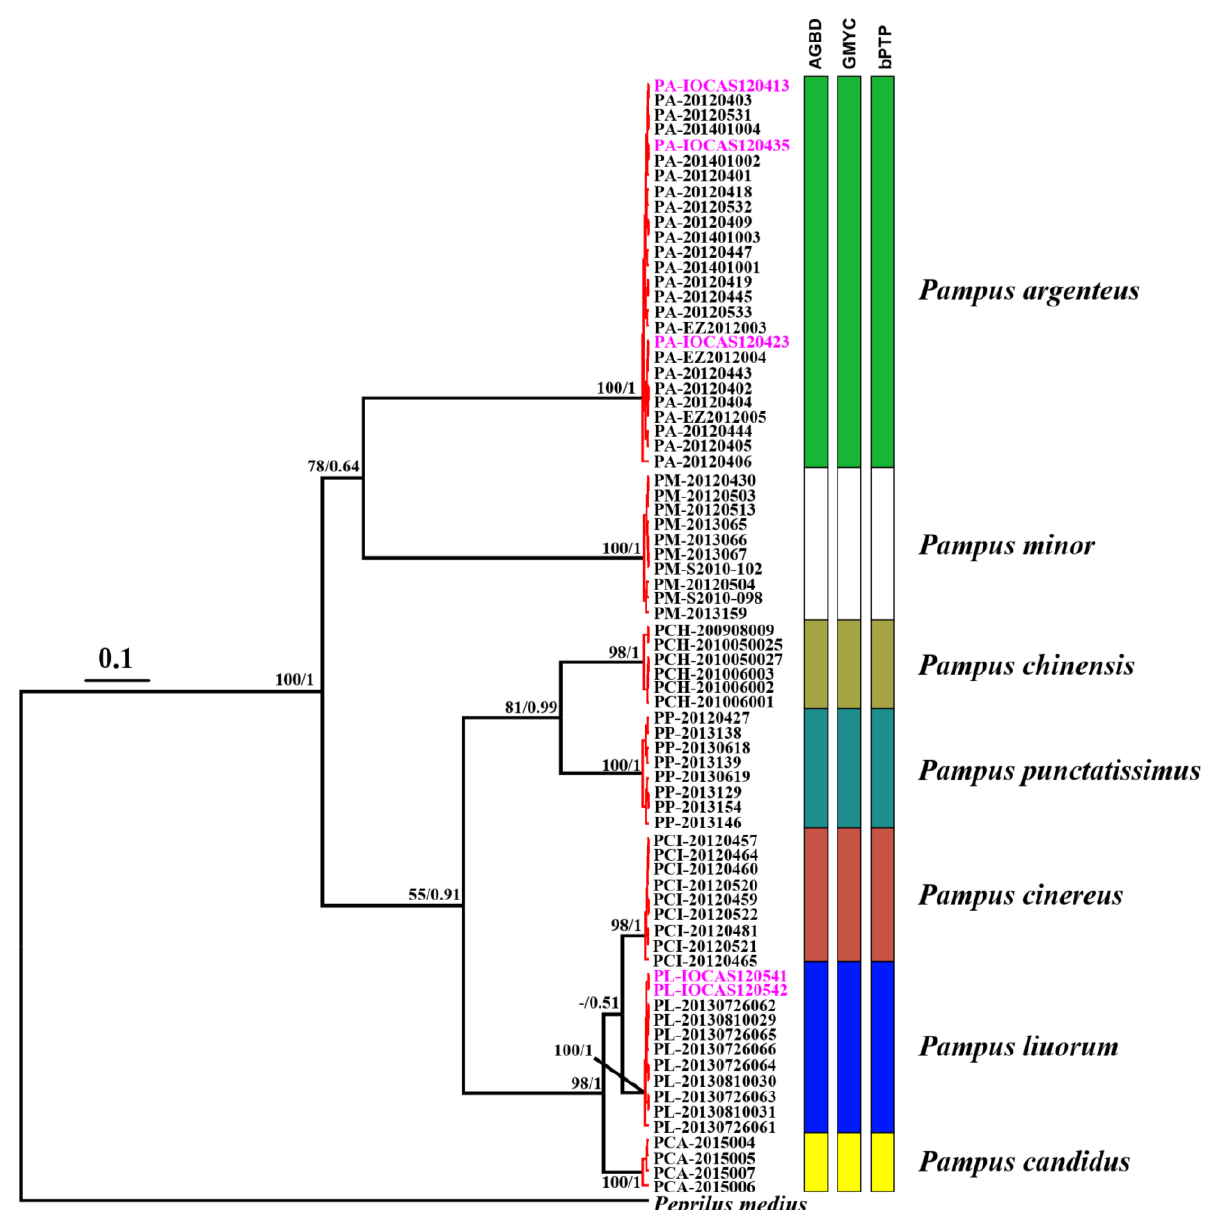
Figure 4. Maximum likelihood tree of the Pampus species inferred from concatenated dataset of COI and Cyt b sequences. Bootstrap values (before slash) and posterior probabilities (after slash) are shown on each node; “ - ” on the node indicates that the node was not included in the maximum likelihood or Bayesian analyses. Results of the two species delimitation methods, i.e., the GYMC and bPTP model, are shown on the left. Specimens in purple are specimens derived from Liu and Li [2] and Liu et al. [3].